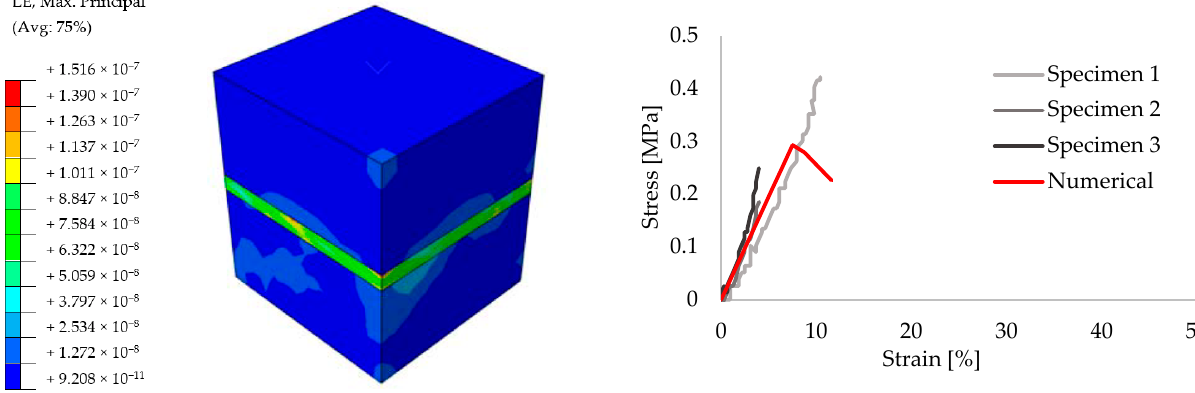
Figure 12. Tension results for the small size specimens with mortar: true strain diagram ( left ) and comparison of the numerical and experimental tests ( right ).